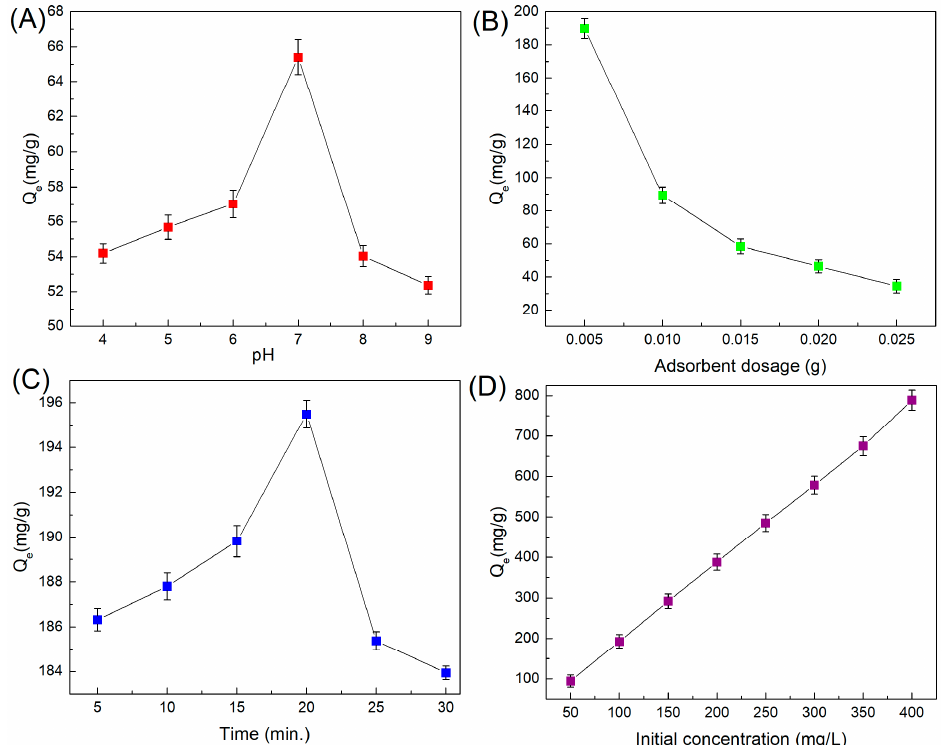
Figure 6. ( A ) Effect of pH (4–9), (biosorbent dose = 0.015 g, amoxicillin concentration = 100 mg/L, time = 15 min and temperature = 298 K), ( B ) biosorbent dosage (0.005–0.025 g), (pH 7, amoxicillin concentration = 100 mg/L, time = 15 min and temperature = 298 K), ( C ) time (5–30 min), (pH 7, biosorbent dosage = 0.005 g, amoxicillin concentration = 100 mg/L, V = 10 mL, and temperature = 298 K), ( D ) amoxicillin concentration (50 – 400 mg/L), ( pH 7, biosorbent dosage = 0.005 g, V = 10 mL, time = 20 min, temperature = 298 K).